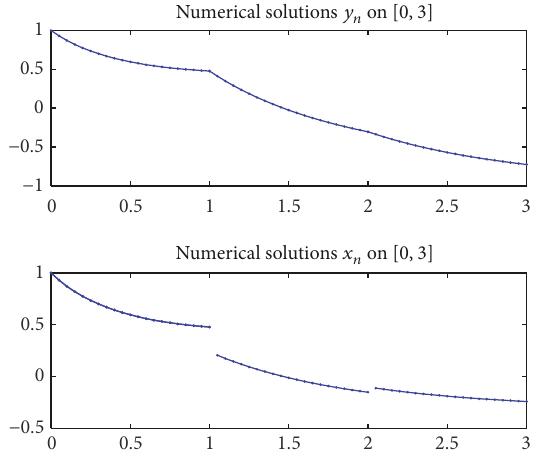
Figure 1: Numerical solutions of (64) and (66) on [0,3] .